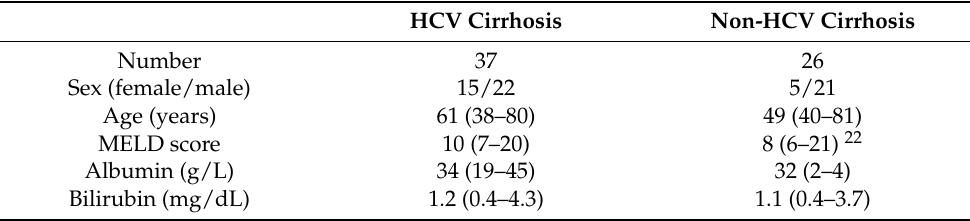
Table 2. Laboratory parameters of the cirrhotic patients with HCV and non-viral disease etiology. *** p <